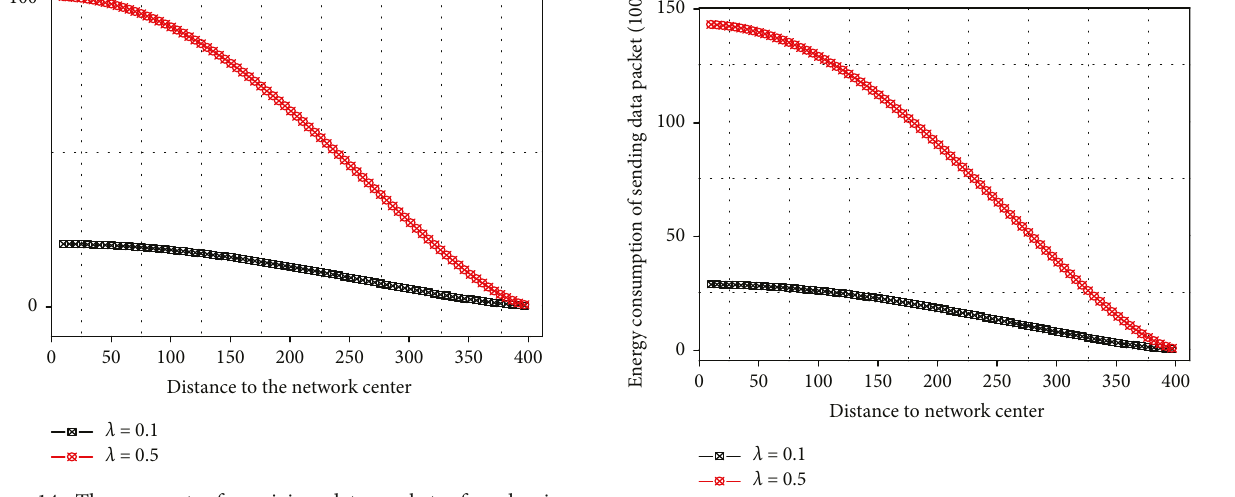
Figure 16: The energy consumption of sending data packet of nodes in di ff erent areas.